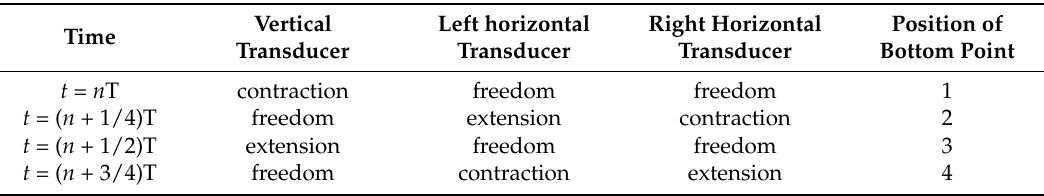
Figure 3. The working principle of the motor. Table 1. The vibrational state of the stator in a period of vibration.